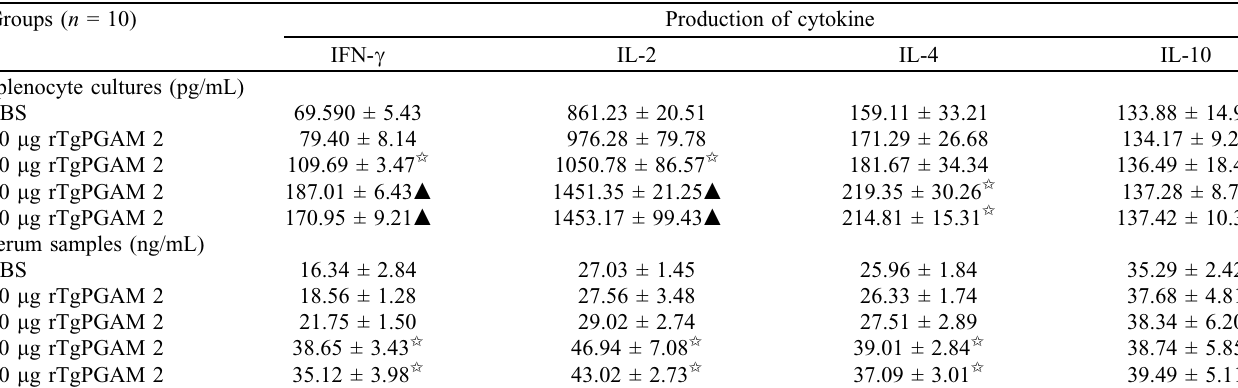
Table 1. Cytokine production in serum samples or splenocyte cultures from immunised BALB/c mice. Groups ( n = 10) splenocyte cultures (pg/mL)